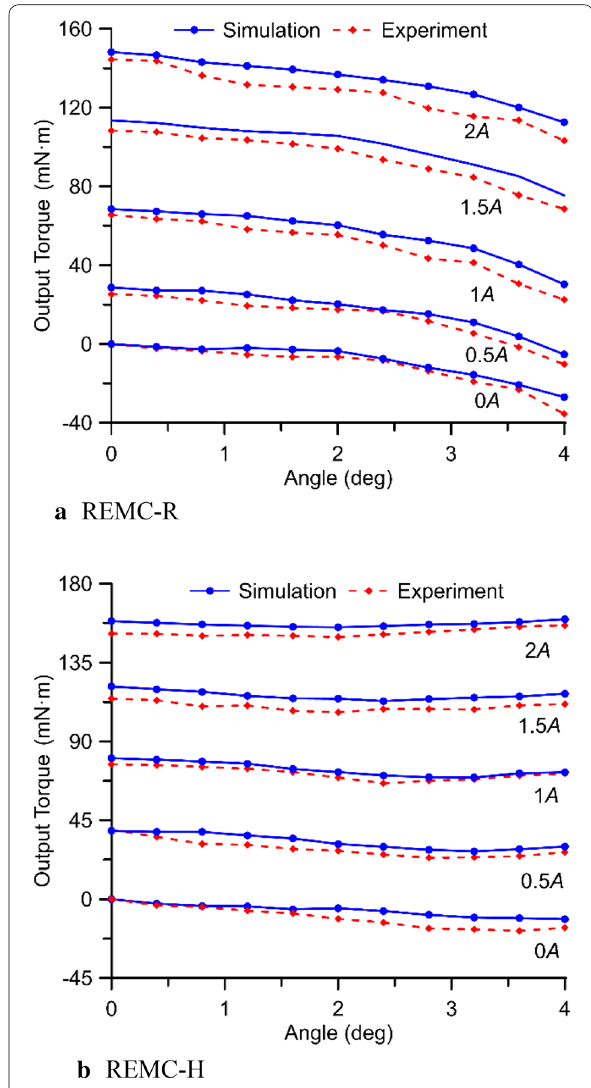
Figure 16 Torque–angle characteristics of REMC-R and REMC-H